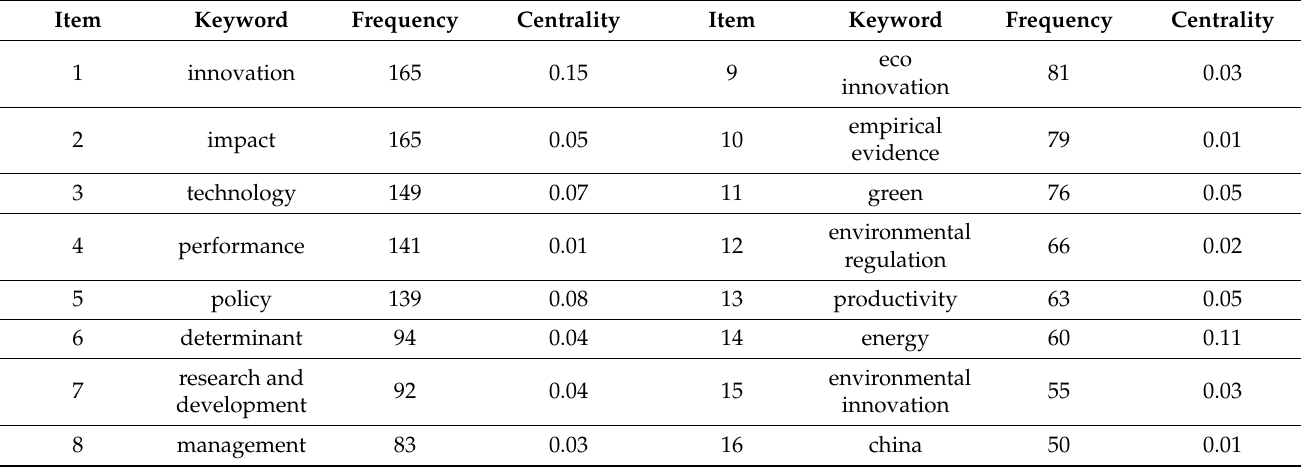
Table 7. Frequency and centrality of TOP 16